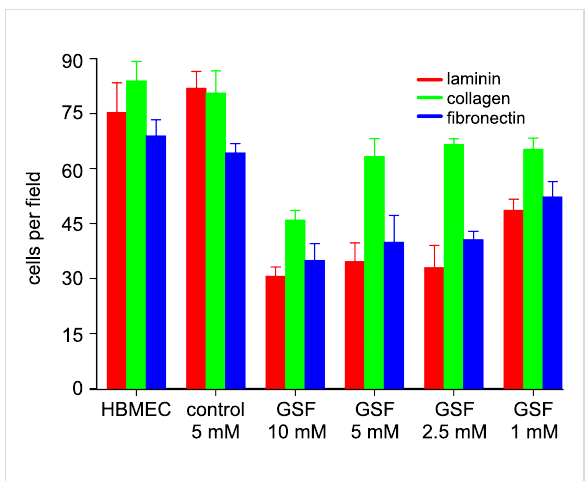
Figure 8: Effect of (4-{[( β -D-galactopyranosyl)oxy]methyl}furan-3- yl)methyl hydrogen sulfate (GSF) on transmigration of HBMEC-60 cells on transwell plates with 8 μ m pores and adhesion to matrix compo- nents on the lower side of the wells. Cells were stimulated with TNF, then GSF or 3,4-bis(hydroxymethyl)furan (control), or medium only (HBMEC), were added. Cells were seeded into transwell inserts coated with extracellular matrix proteins as indicated. After incubation for 30 min nonadherent cells were washed away, and cells sticking to the proteins were fixed, stained and quantified. Shown is an exem- plary experiment with TNF-stimulated HBMEC-60 cells. The experi- ments were performed in triplicate and in three independent experi- ments for each extracellular matrix